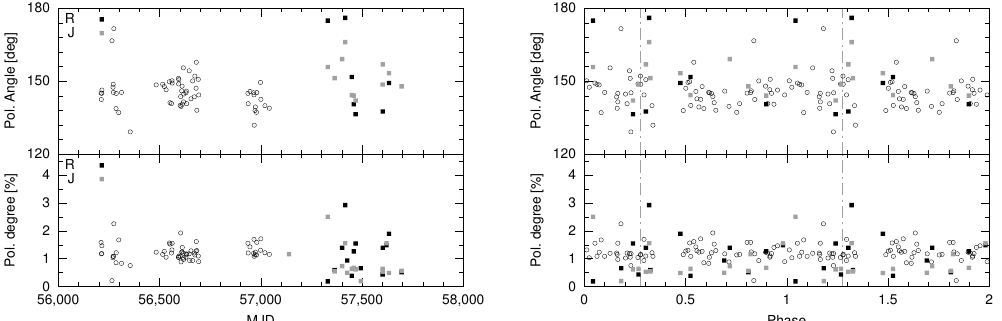
Figure 4. R - (black) and J -band (gray) polarization data of LSI + 61 303 with Kanata/HOWPol (open circles, until MJD 57037, R -band) and Kanata/HONIR (filled square, from MJD 57143, R - and J -bands), over the whole observation period ( left ) and regarding the phase ( right